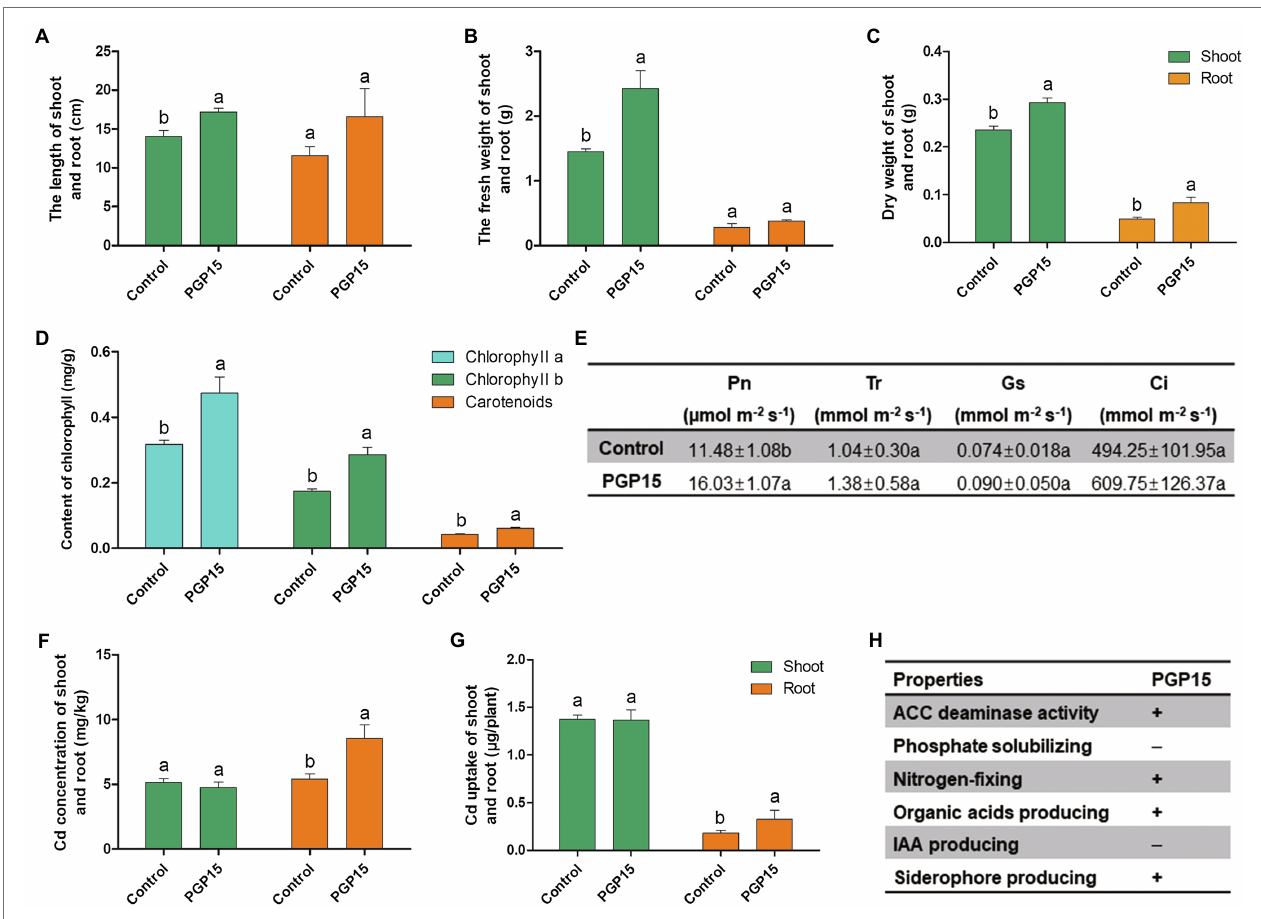
FIGURE 3 | Promotion of growth, Cd accumulation and alleviation of Cd-induced stress in Solanum nigrum by strain PGP15. The lengths (A) fresh weights (B) and dry weights (C) of shoots and roots are shown. (D) Chlorophyll a, chlorophyll b and carotenoid contents. (E) The effects of PGP15 inoculation on photosynthesis rate (Pn), transpiration rate (Tr), stomatal conductance (Gs), and intercellular CO 2 concentration (Ci). (F) The Cd concentrations in shoots and roots. (G) Total Cd accumulation in shoots and roots. (H) Basic growth-promoting properties of strain PGP15. The activities detected in strain PGP15 are indicated with a plus sign. IAA, indole-3-acetic acid; ACC, 1-aminocyclopropane-1-carboxylate.